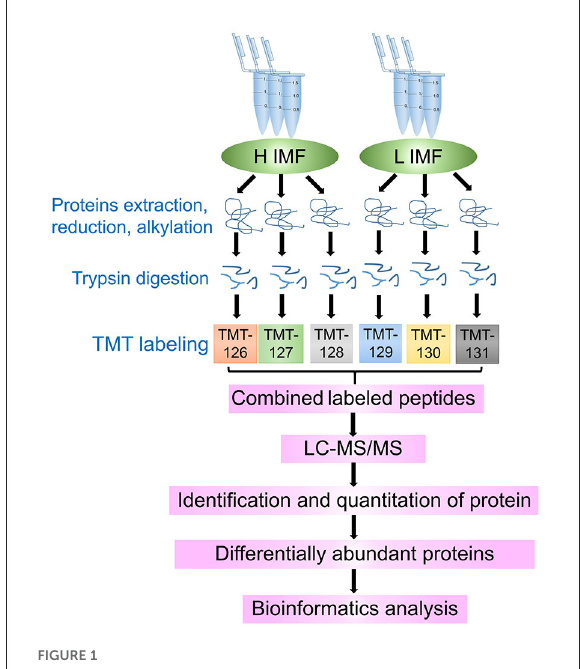
FIGURE1 Schematic protocol for the identification of longissimus dorsi muscle proteins from tissue samples with high (H) and low (L) intramuscular fat (IMF) content using tandem-mass-tagged (TMT)-labeled quantitative proteomics. The H and L IMF samples were in triplicate, and each sample used a different TMT